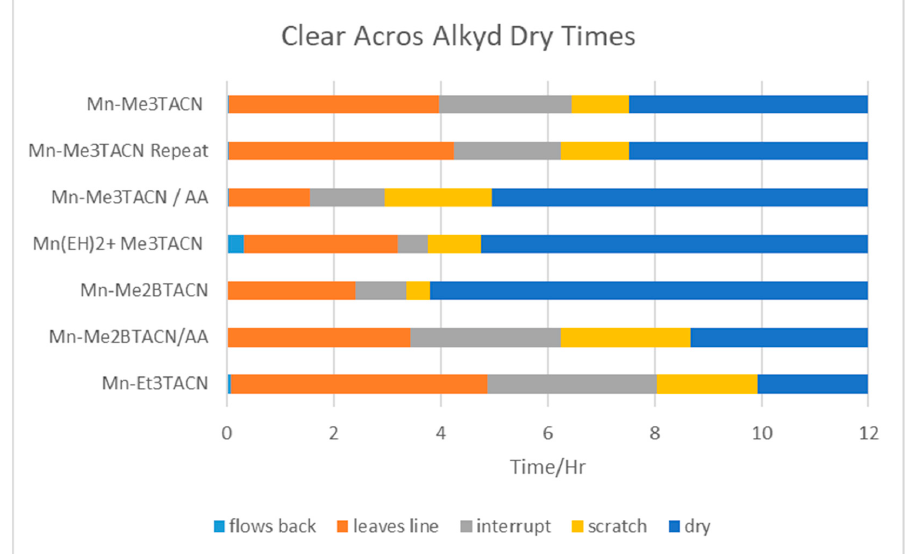
Figure 8. Drying times of alkyd resin in the presence of 0.01 wt% Mn added as [Mn IV2 ( μ - O) 3 (Me 3 TACN) 2 ](PF 6 ) 2 (abbr. as Mn-Me 3 TACN), [Mn IV2 ( μ -O) 3 (Me 3 TACN) 2 ](PF 6 ) 2 with one